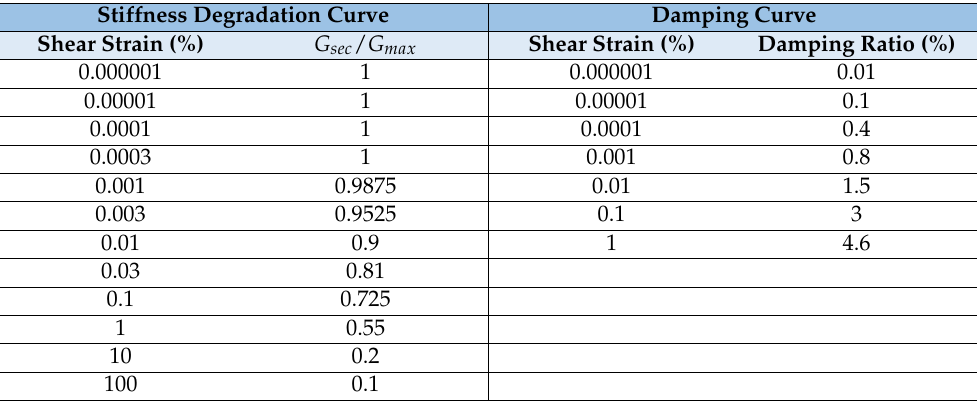
Table A3. Dynamic properties for bedrock.